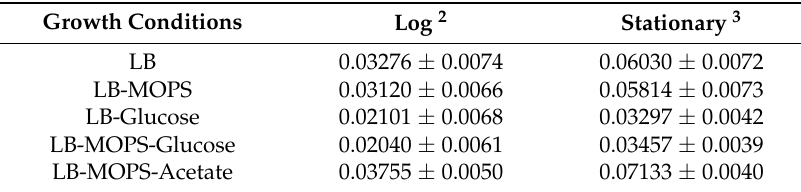
Table 6. Staphyloxanthin content 1 (OD 465 /mg of dry cell mass) in Pig1 grown in various LB broths. Growth Conditions